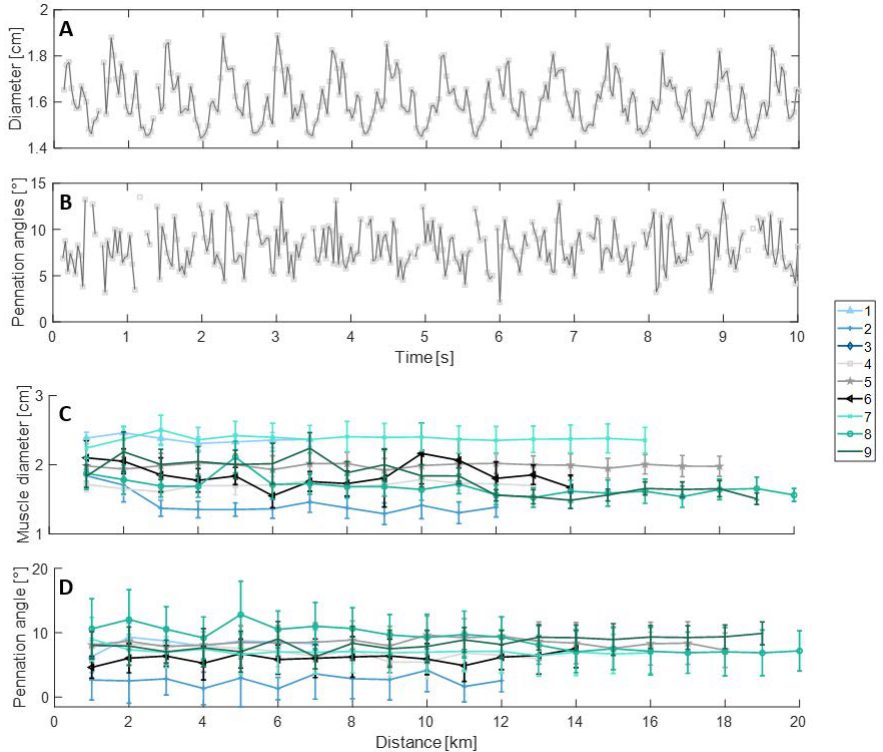
Figure 5. Dynamic functional measurements. For all acquisitions, the thickness of the muscle and the pennation angle of the fascicles are computed. ( A , B ) are examples of these computations. These two examples were derived from the ultrasound images obtained at the 7th kilometer in subject 4. In ( A ) the cyclic contraction of the muscle is visible, whereas the pennation angles contain relatively more noise. ( C , D ) display the mean muscle thickness and the pennation angle for all kilometers. The error bars show the standard deviation of each acquisition, representing the variation within the gait cycle, which is a result from muscle contraction. The muscle thickness and pennation angle are roughly contact over